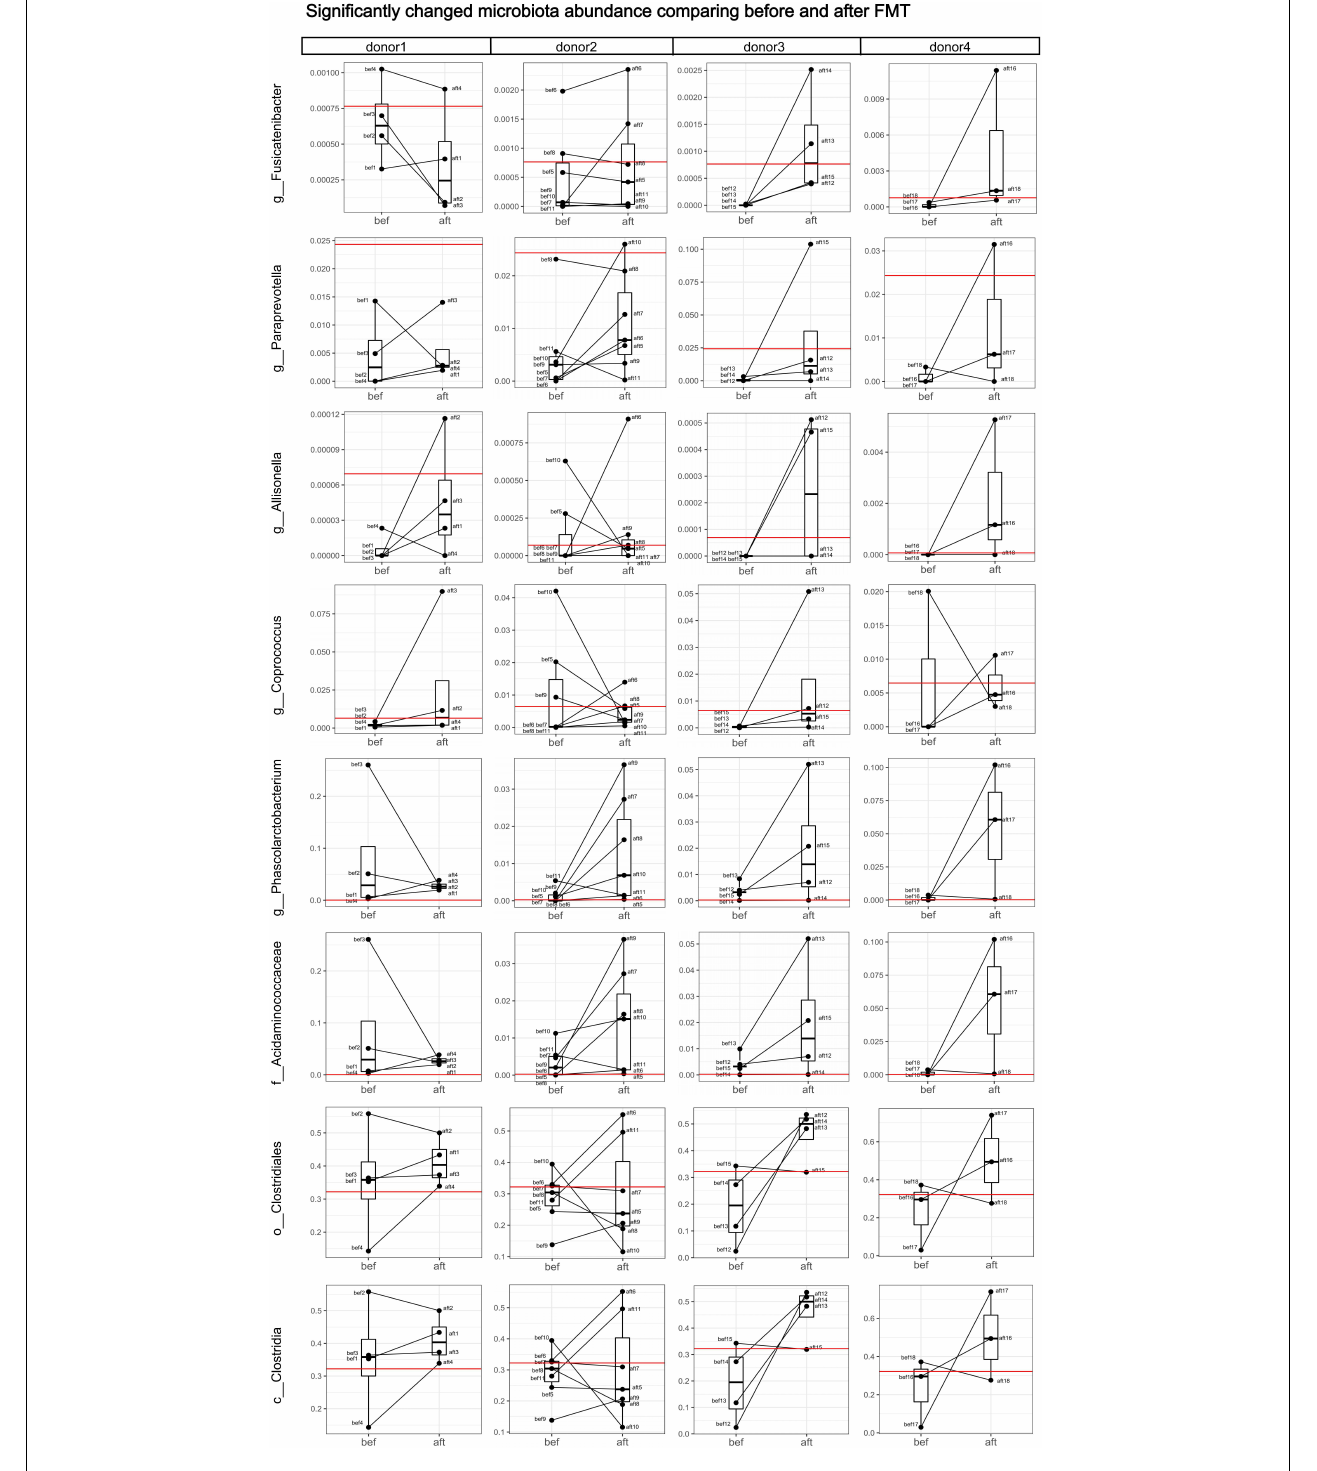
FIGURE 5 | Analyses of abundance changes in post-FMT-enriched bacteria in each donor-recipient pair. Boxplots comparing the bacterial abundances before and after FMT are shown. Each black dot represents one sample (patient); pre-FMT and post-FMT samples from the same patient are connected by a black line. Red horizontal lines represent the donor. One failed patient had a decreased abundance of Paraprevotella after FMT, and failed Patients 2, 4, and 5 had decreased abundances of Fusicatenibacter after FMT. The recipients of Donors 1 and 2 had more decreased bacterial abundances compared with the increased bacterial abundances in the recipients of Donors 3 and